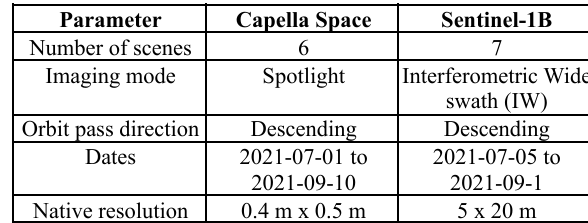
Table 8. Imaging parameters for Capella Space and Sentinel-1B datasets used in the mining case study.